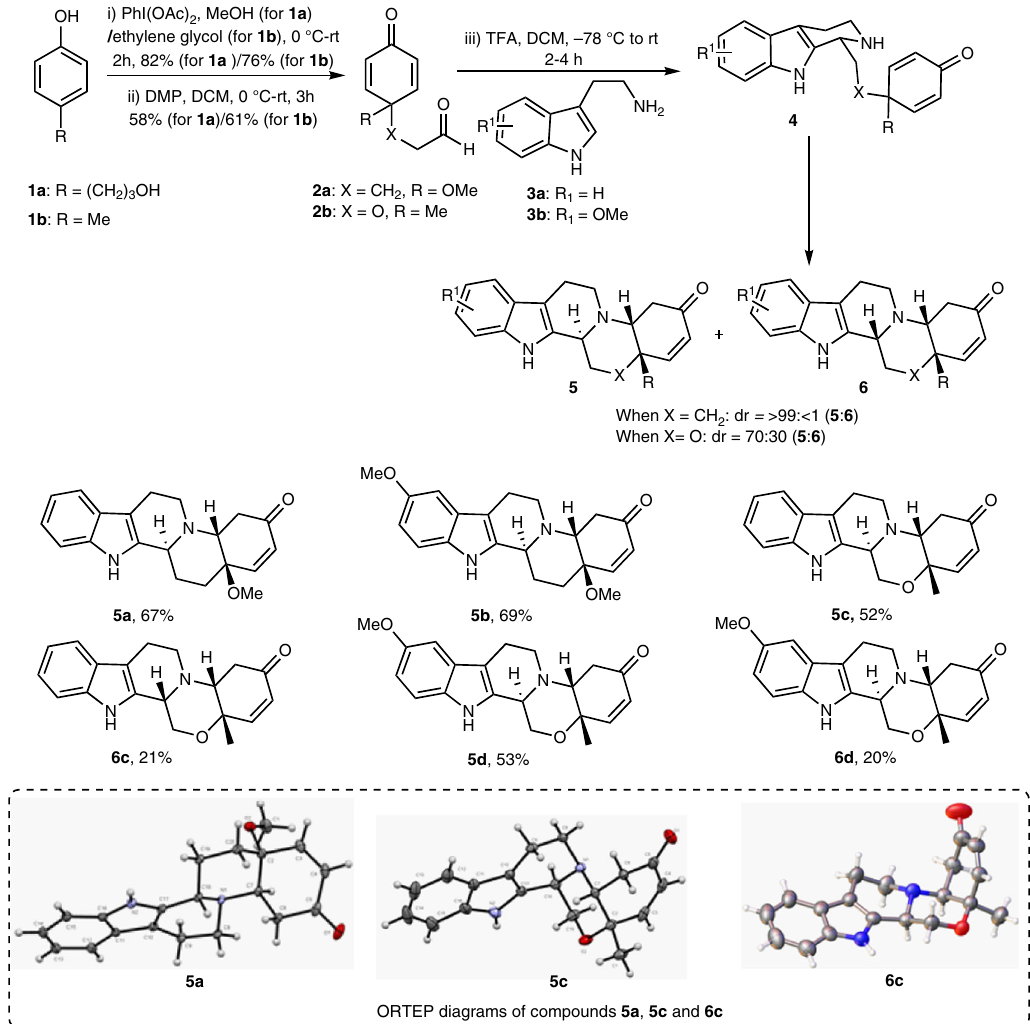
Fig. 3 Diastereoselective synthesis of polycyclic octahydroindolo[2,3-a]quinolizines. ORTEP diagrams of compounds 5a , 5c, and 6c . PhI(OAc) 2 , (diacetoxyiodo)benzene; MeOH methanol, DMP Dess-Martin